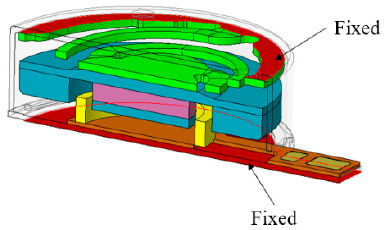
Figure 5. The boundary conditions of the linear vibration motor.